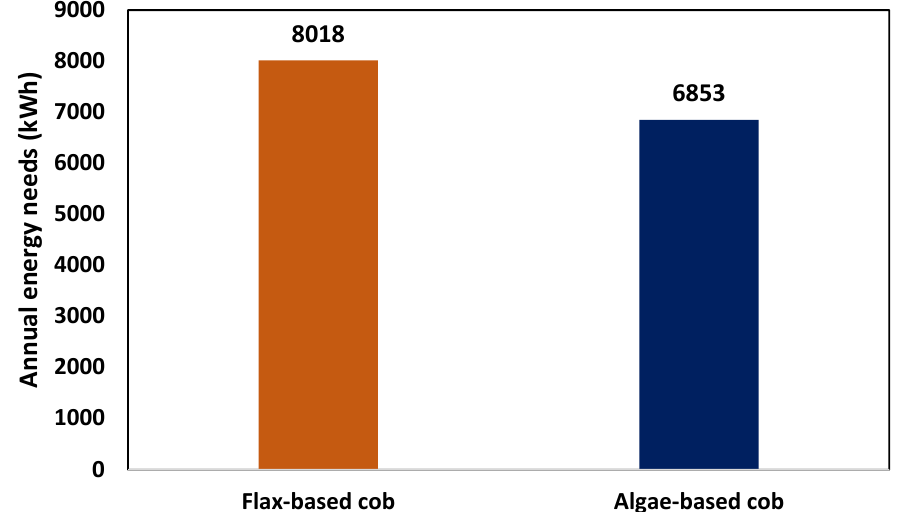
Figure 12. Calculation of heating and cooling needs in housing with an envelope made with algae- based cob and a flax-based cob.